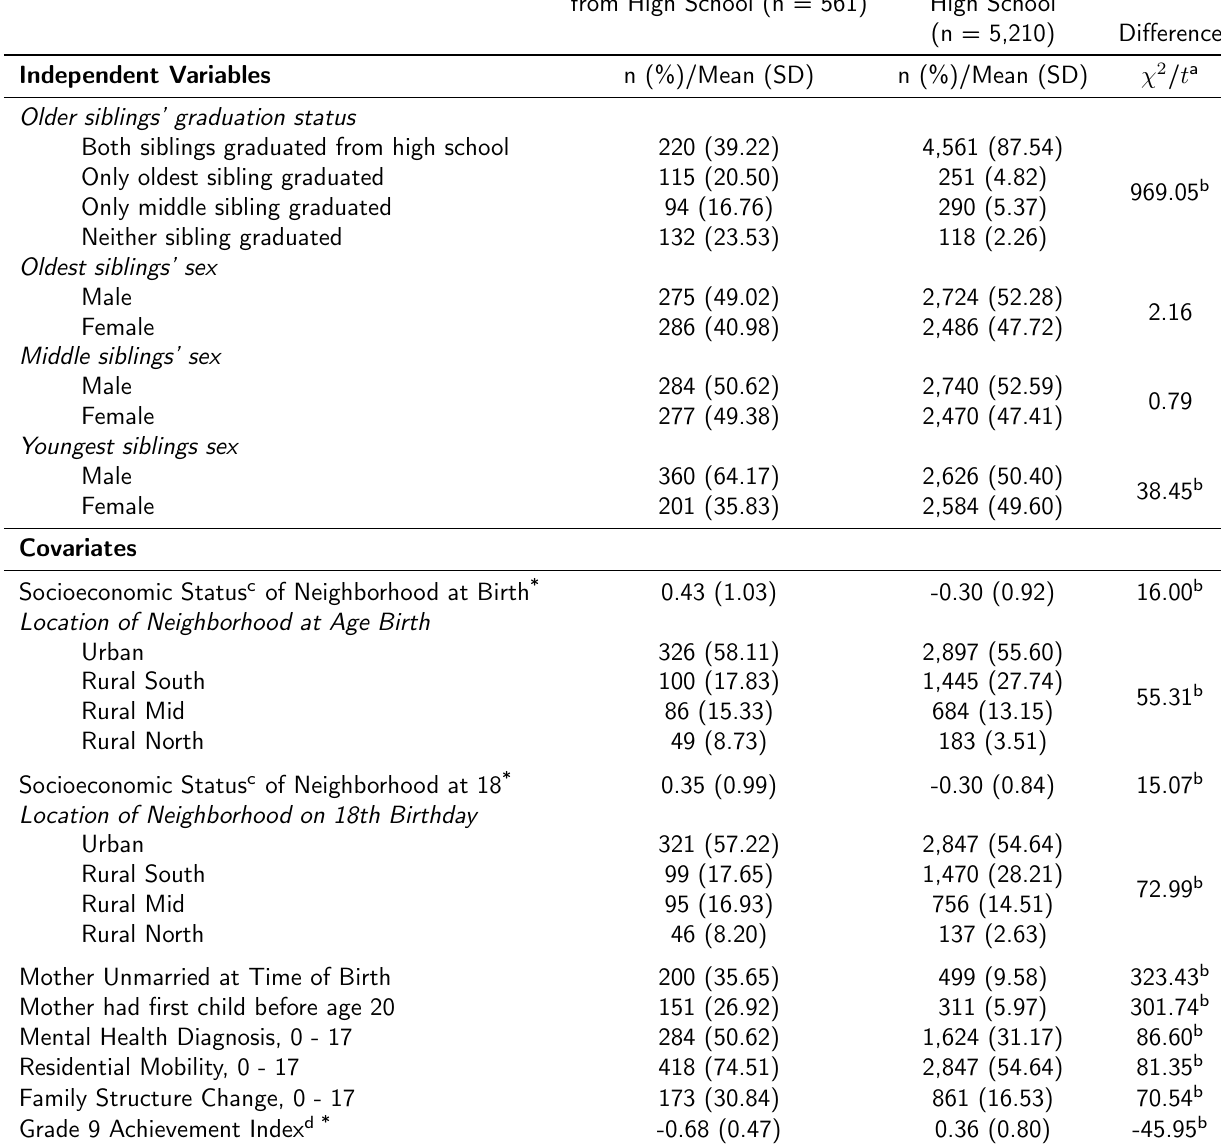
Table 1: Descriptive statistics of covariates for third siblings in three child families (n =